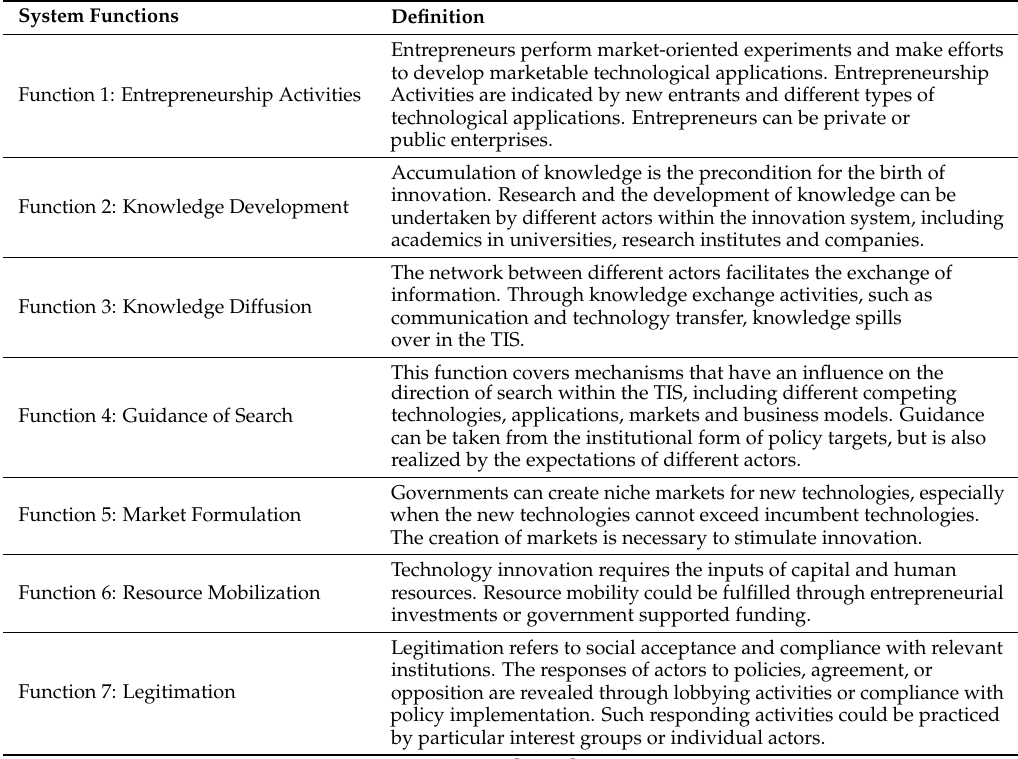
Table 2. Definitions of TIS